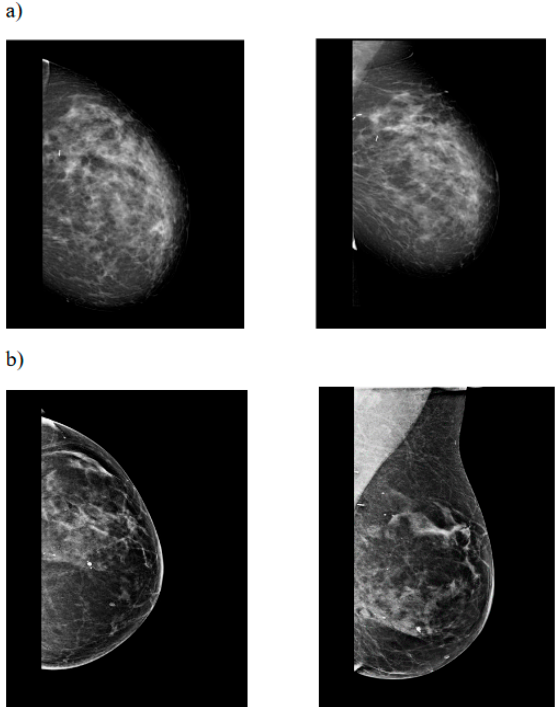
Figure 2. Cranio-caudal ( left side) and medio-lateral oblique ( right side) projection of left breast; ( a ) preoperative imaging ( b ) post-operative imaging. No architectural change and/or post-operative breast tissue modification is appreciable.